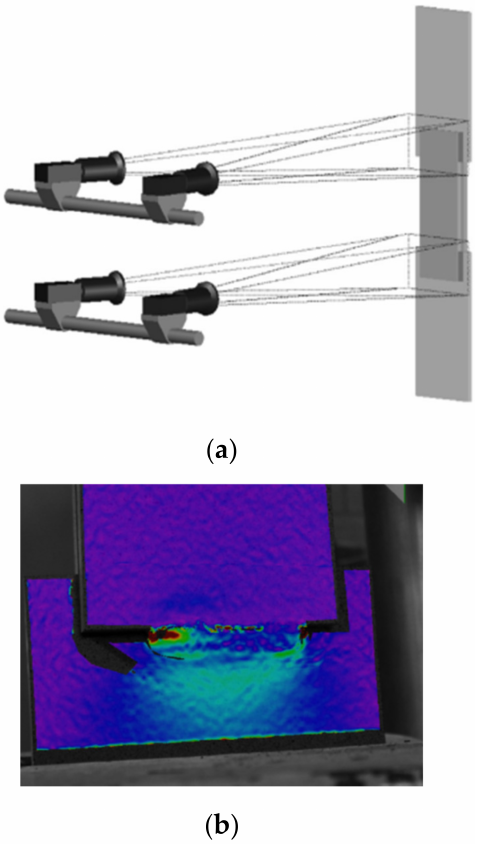
Figure 8. DIC setup and measurements for fillet welded joint (used with permission, Elsevier [29,32]). ( a ) DIC measurement set-up; ( b ) Measured strain pattern for transverse fillet